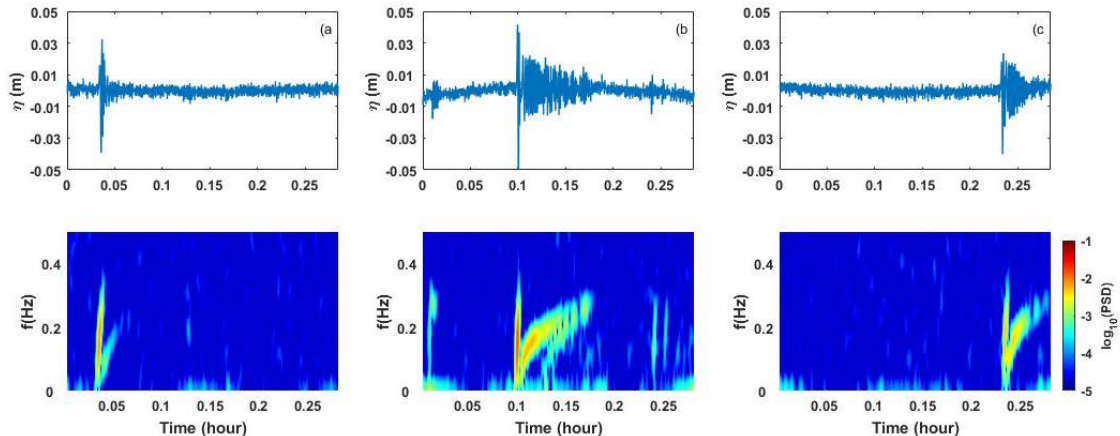
Figure 4. Selected wake events observed during the eight deployment at CP. Top panels show the 17-min burst time series of surface elevation. Bottom panels show the wakes Spectrograms. ( a ) Wake event in 22nd July at 6:30 pm, ( b ) wake event in 26th July at 6 am, and ( c ) wake event in 27th July at 1 1 pm.